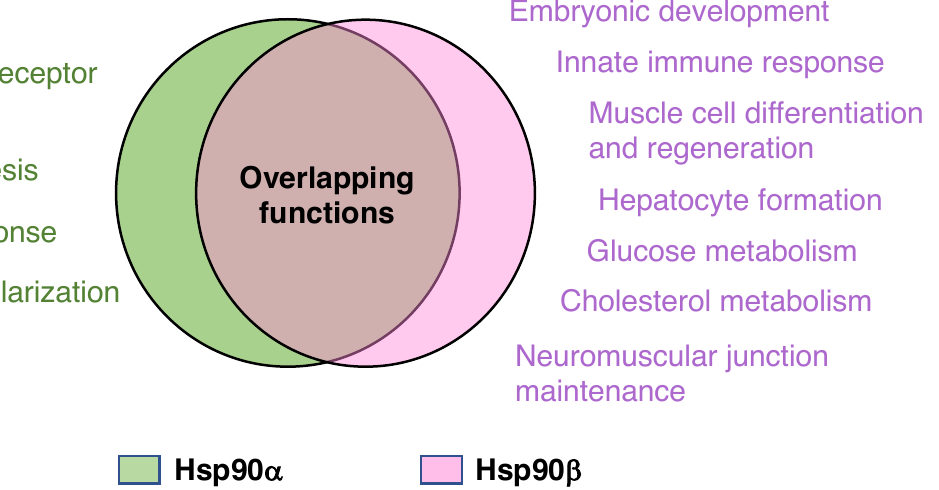
Figure 2. Venn diagram of common and isoform-specific functions of Hsp90. Isoform-specific functions, as discussed in the text, are highlighted in the corresponding